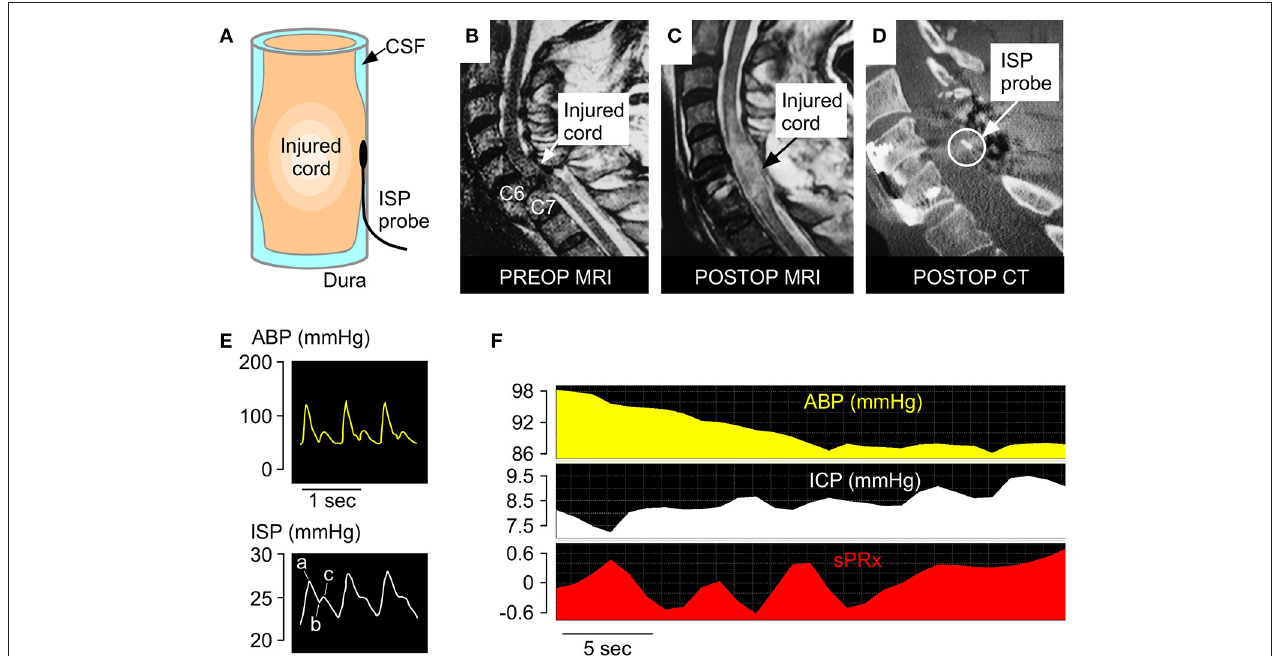
FIGURE 1 | ISP monitoring technique . (A) Schematic showing intradurally placed ISP probe. (B) Pre-operative T2 MRI of a patient with TSCI at C6-7. (C) Postoperative T2 MRI of same patient. (D) Postoperative CT of same patient with ISP probe in situ . (E) Examples of ABP (yellow) and ISP (white) signals. Percussion peak (a), dicrotic notch (b), dicrotic peak (c). (F) Examples of ABP, ISP, and sPRx recordings.